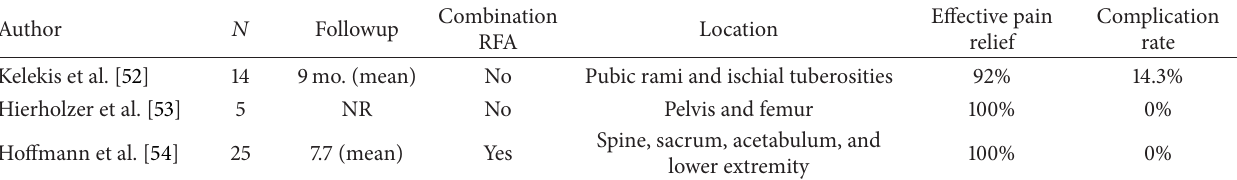
Figure 4: Plasmacytoma of L2 (a) treated with vertebroplasty (b). Table 5: Summary of cementoplasty studies in metastatic